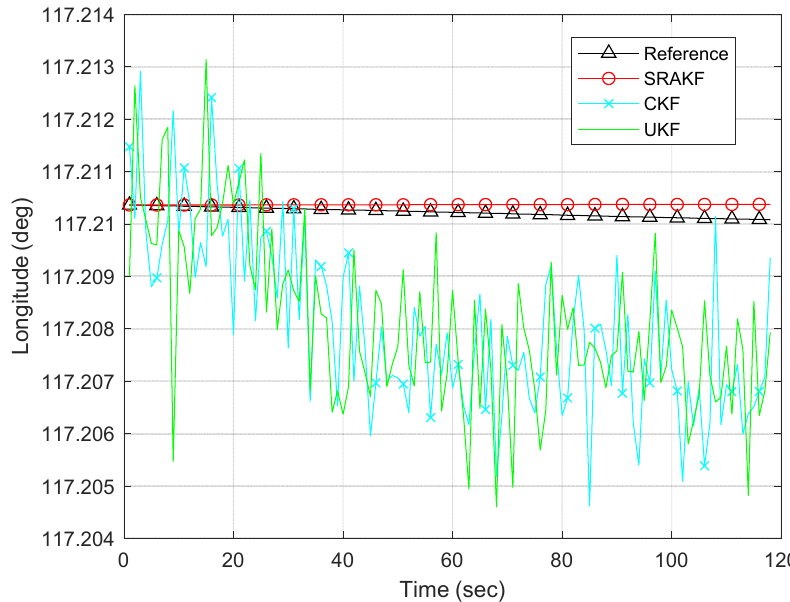
Figure 16. Longitude positions for the robustness lake trial.